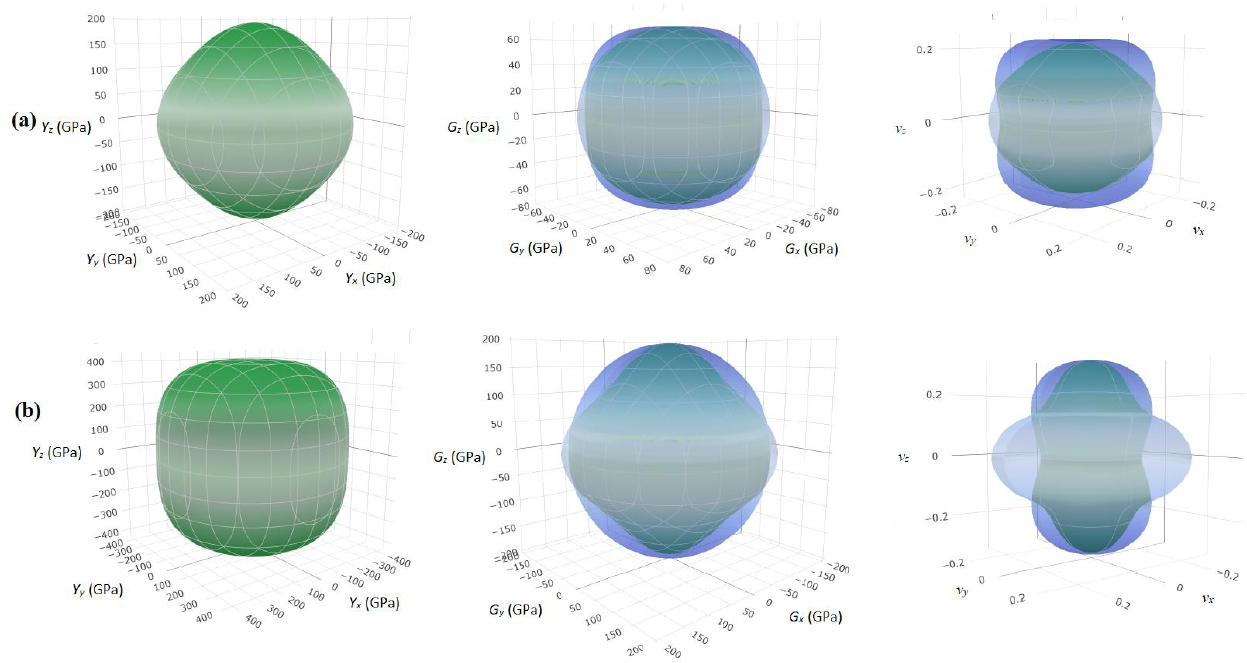
Figure 7. 3D plot of Young’s modulus, shear modulus, and Poisson’s ratio surfaces of Zr 2 PbC at pressure ( a ) 0 GPa and ( b ) 100 Gpa.